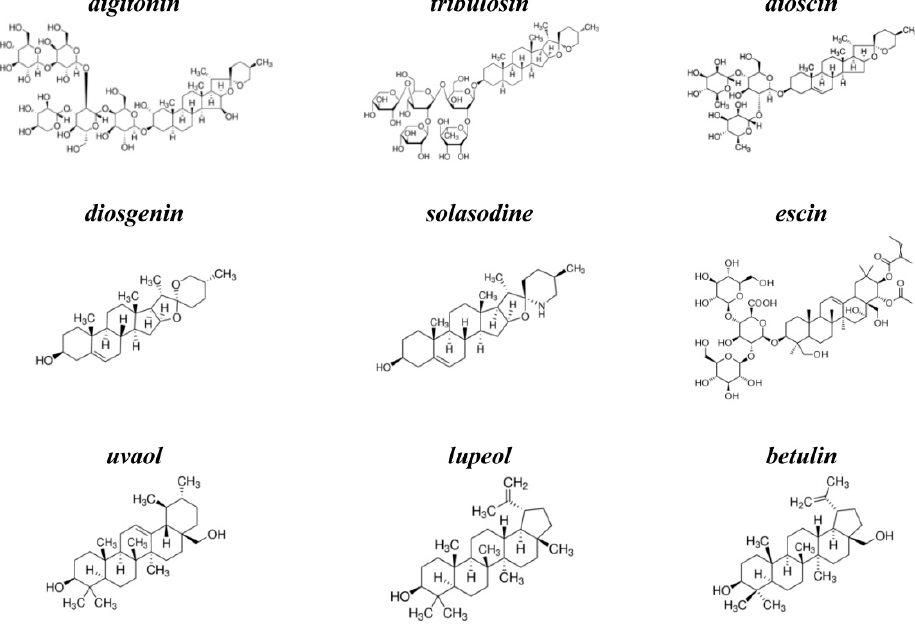
Figure 6. The chemical structures of tested agents: steroid saponins, digitonin, tribulosin, dioscin; steroid sapogenin, diosgenin; steroid alkaloid, solasodine; triterpenic saponin, escin; and triterpenic sapogenins, uvaol, lupeol, and betulin.